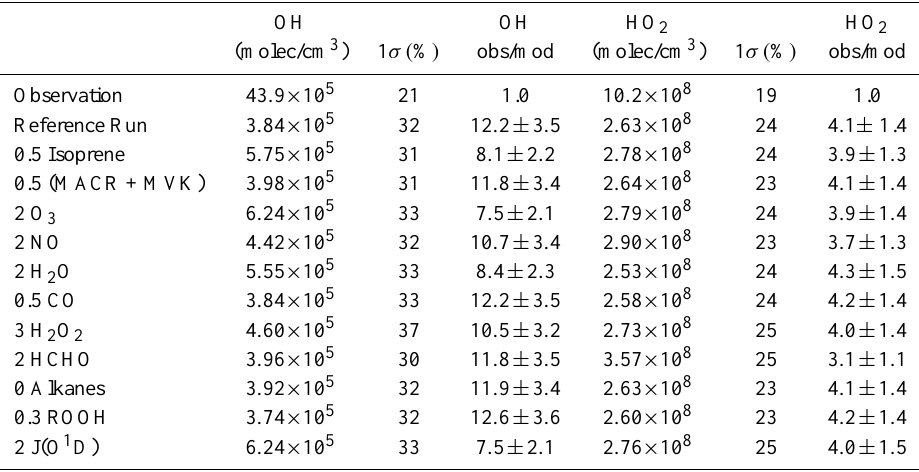
Table 4. Sensitivity studies with MECCA concerning the constrained measured species. Concentrations are mean values for the forest boundary layer ( < 1km) in the afternoon